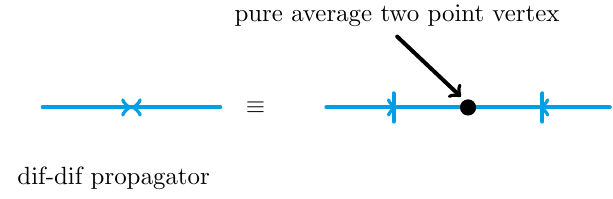
Figure 21. Pure di(cid:11)erence propagator from loop